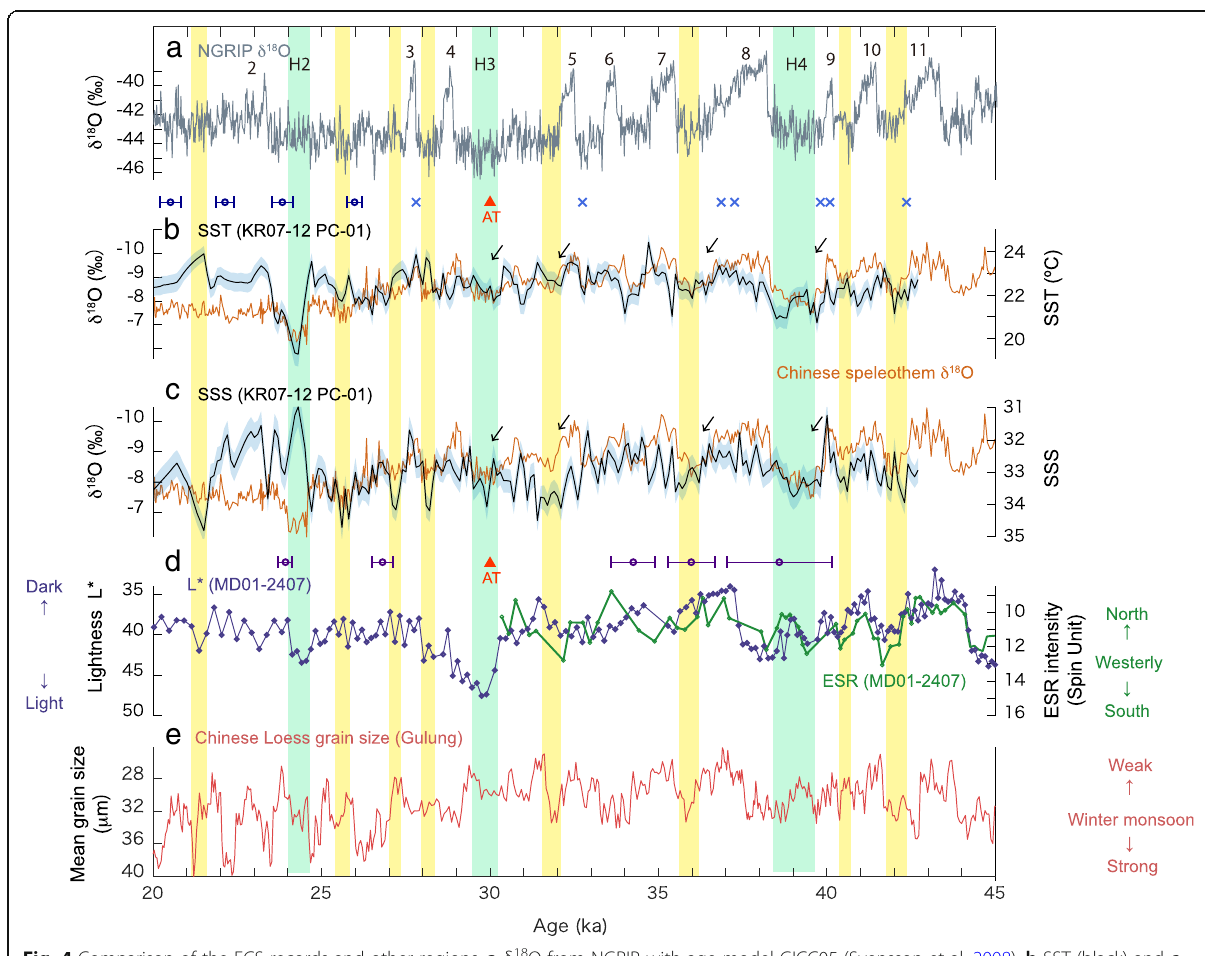
Fig. 4 Comparison of the ECS records and other regions. a δ 18 O from NGRIP with age model GICC05 (Svensson et al. 2008). b SST (black) and c SSS (black) of KR07 – 12 PC-01 with 1 σ uncertainties superimposed on δ 18 O sp (orange) from China (Cheng et al. 2016). d L* (purple; Bassinot and Blatzer 2002) and ESR (green; Nagashima et al. 2011) of MD01-2407 in the Japan Sea, recalibrated to IntCal13. e Gulang mean grain size, Loess Plateau, China (Sun et al. 2012). Heinrich events 2 (H2), 3 (H3), and 4 (H4) are highlighted in blue. D-O cycle numbers are shown in the NGRIP δ 18 O. The high SSS events in the ECS are highlighted in yellow. The 14 C-based datums (circles) and tie points (crosses) are shown in b for KR07-12 PC-01 and in d for MD01-2407. Red triangles (AT) represent AT